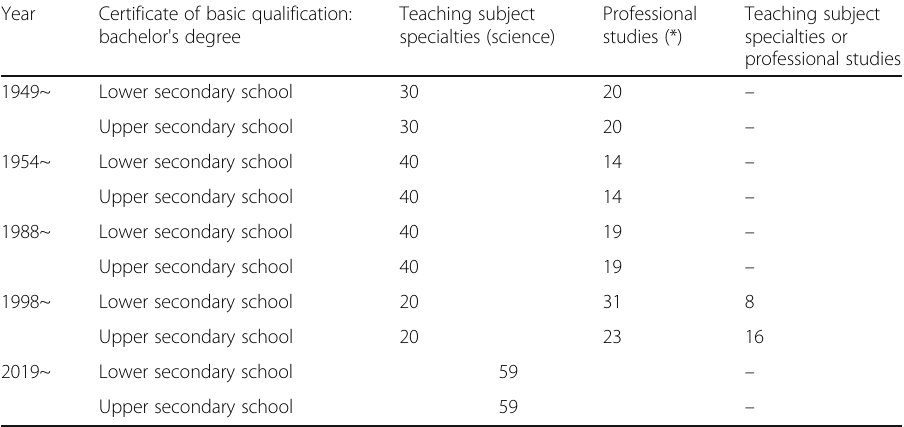
Table 1 The minimum number of credits of teaching subject specialties and professional studies for a teacher certificate